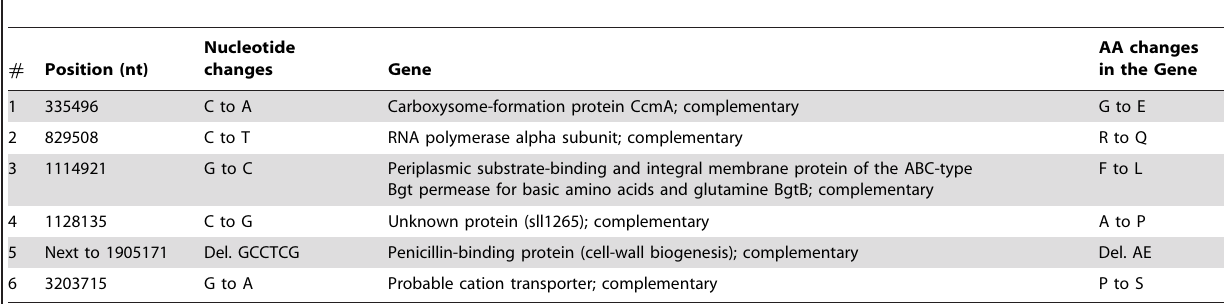
Table 1. Genetic changes detected in the evolved cells relative to the ancestral